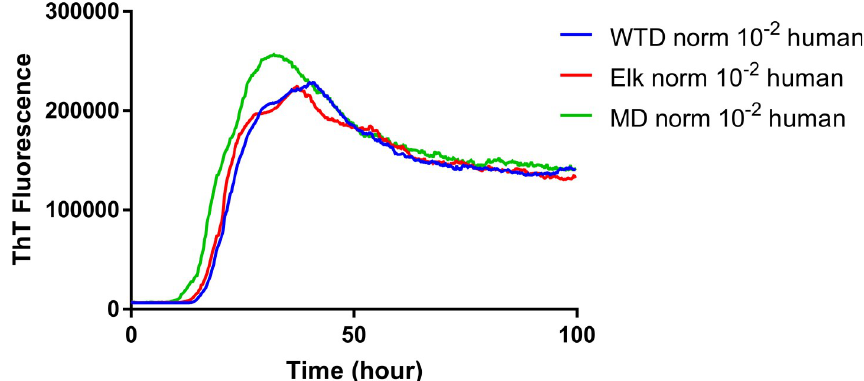
Fig 10. Comparison of averaged seeding activity of RT-QuIC reactions with human rPrP seeded with 10 − 2 dilution of EIA normalized brains from reindeer inoculated with brains of infectious cervid species. (WTD: blue line, elk: red line, MD: green line). All assays from each CWD source was averaged and compared to assays seeded with different CWD inocula. Data are presented as mean ThT fluorescence of 4 repeated reactions.